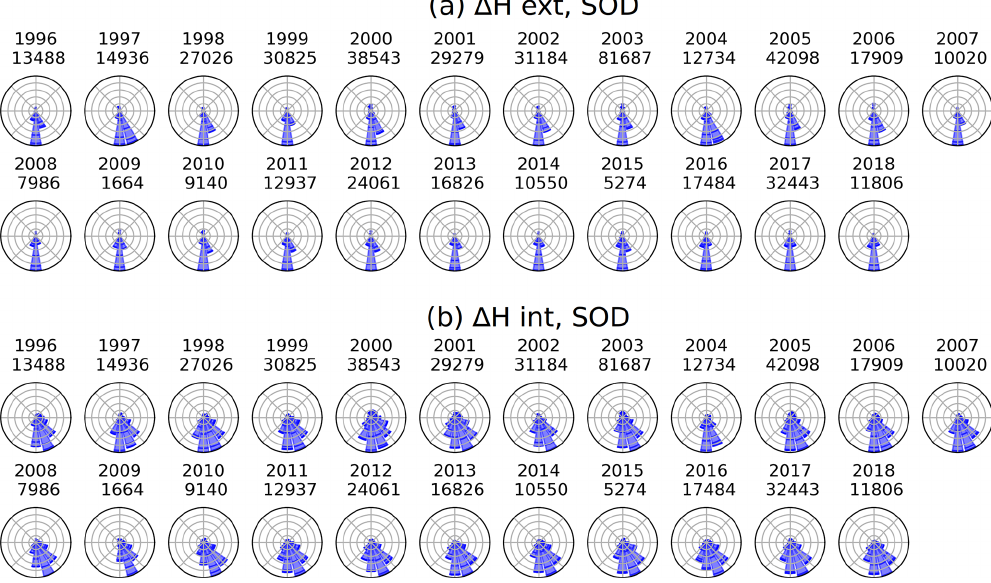
Figure 7. Directional distribution of (a) (cid:49) H ext and (b) (cid:49) H int at Sodankylä (SOD) between 1996–2018 when | d (cid:49) H / d t | > 1nTs − 1 . The number of data points is plotted below the year label.